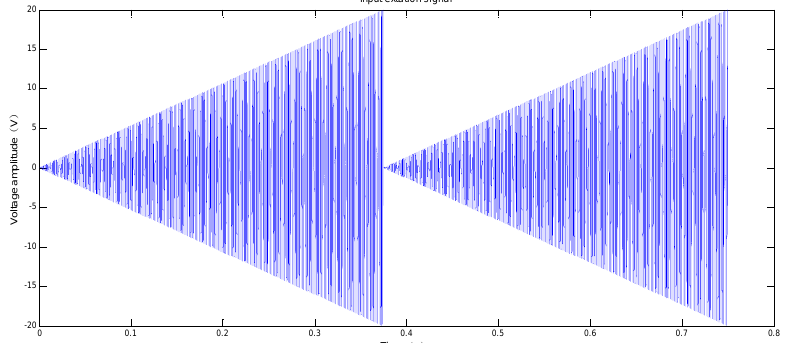
Fig.3 amplitude modulating excitation voltage signal